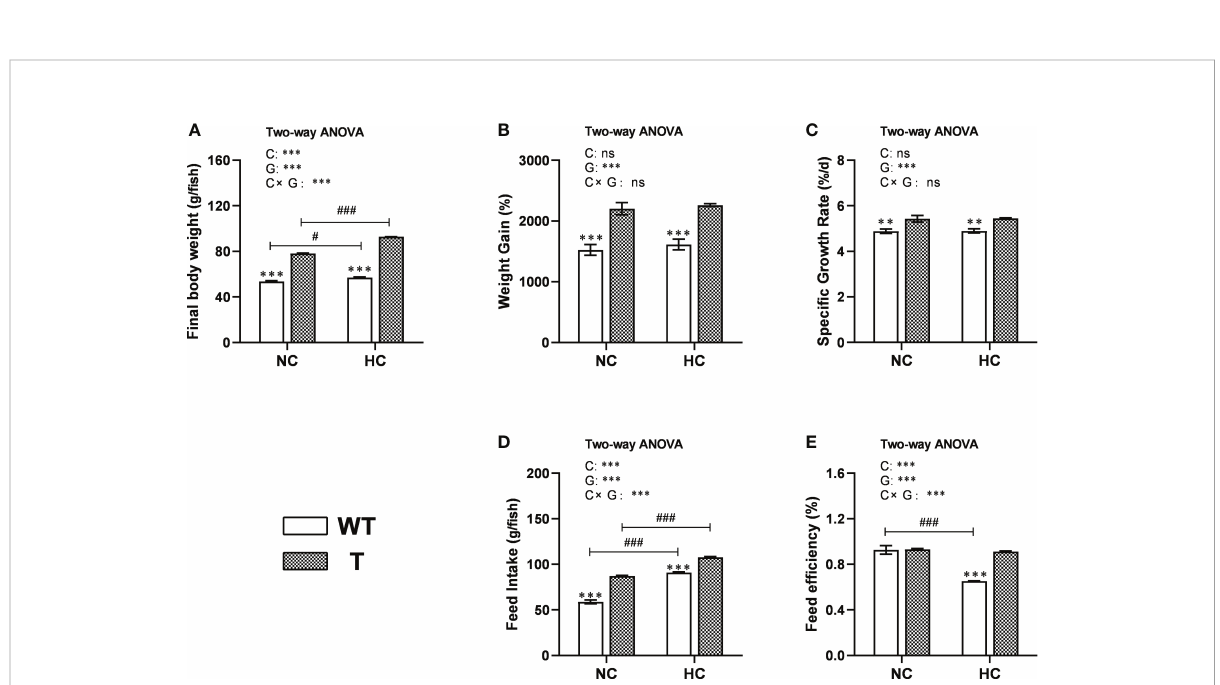
FIGURE 4 Growth performance of T and WT common carp fed a normal starch or high-starch diet. (A) Final body weight. (B) Weight gain. (C) Speci fi c growth rate. (D) Feed intake. (E) Feed ef fi ciency (n = 3). WT, wild-type common carp. T, GH transgenic common carp. NC, diet containing 30% starch. HC, diet containing 40% starch. ** and *** indicate a signi fi cant difference ( P < 0.01, and P < 0.001, respectively) in different strains at same dietary starch content. # and ### indicate a signi fi cant difference ( P < 0.05 and P < 0.001, respectively) in the same strain with different dietary starch contents. In two-way ANOVA, C, carbohydrate; G, GH. *** P < 0.001, ns indicates no signi fi